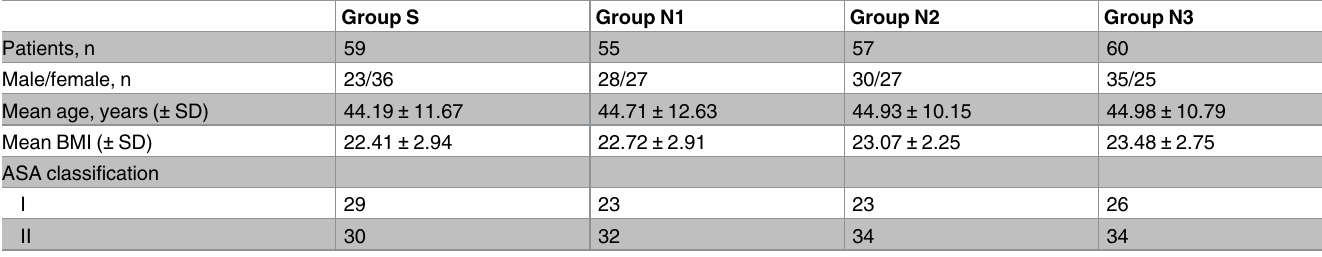
Table 2. Patient demographic characteristics.